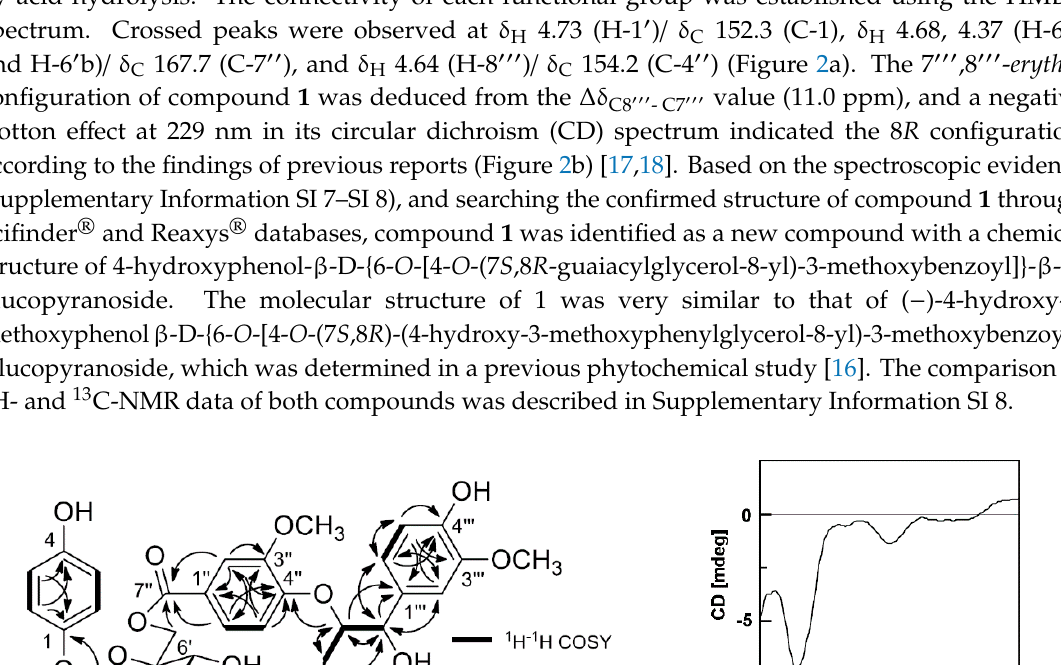
Figure 1. The sugar unit was identified as D ‐ glucose by acid hydrolysis. The connectivity of each functional group was established using the HMBC spectrum. Crossed peaks were observed at  H 4.73